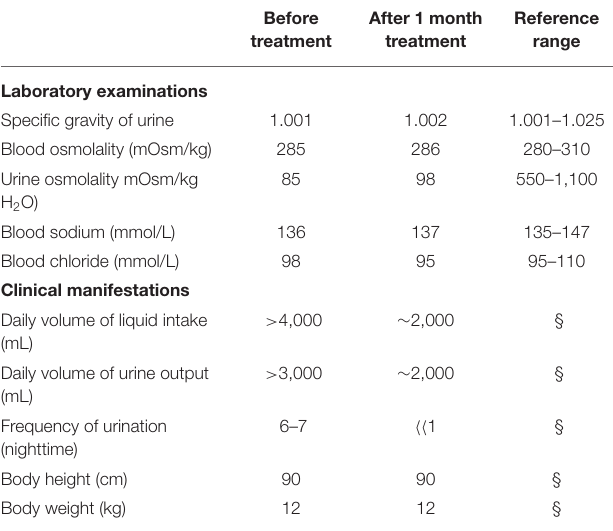
TABLE 1 | Results of laboratory examinations and clinical manifestations before and after treatment. Before